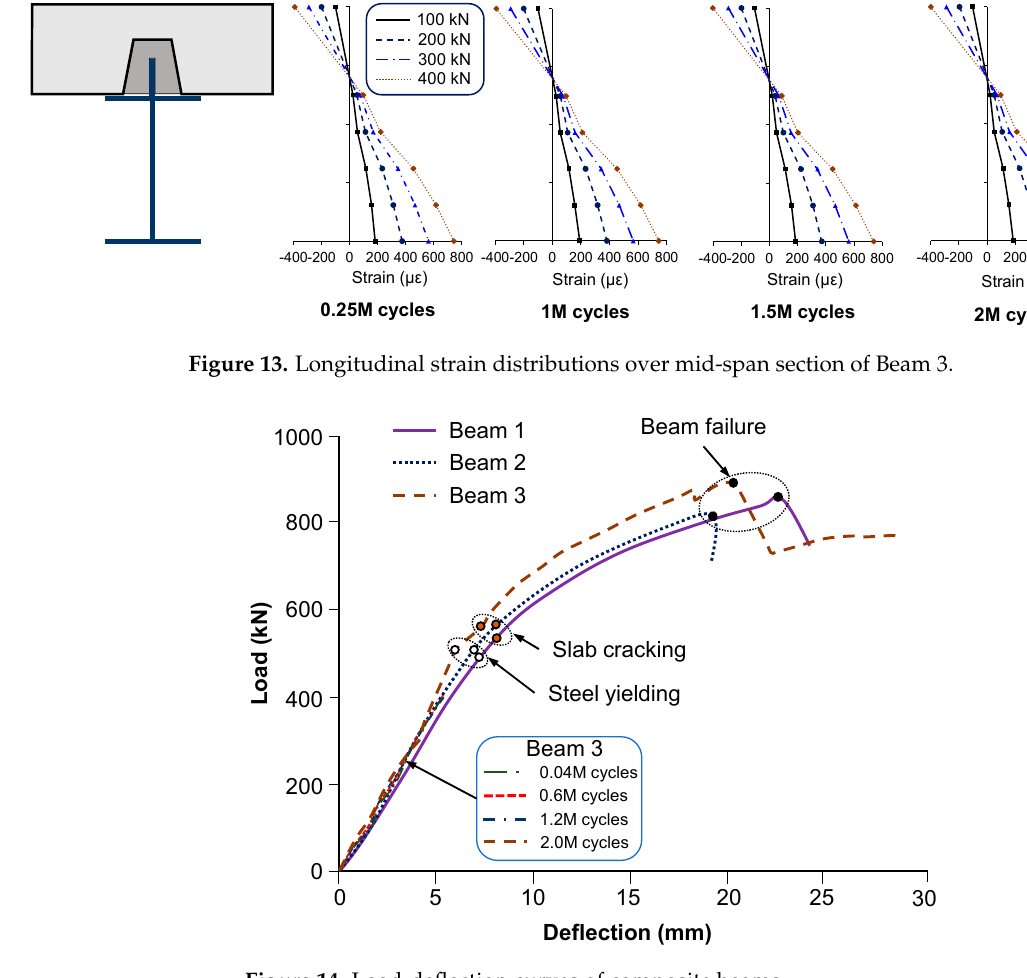
Figure 14. Load-deflection curves of composite beams.